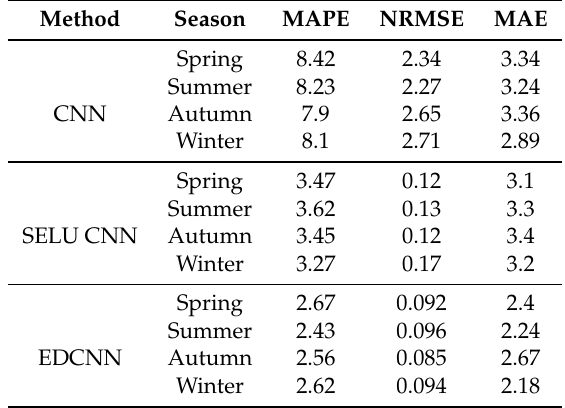
Table 3. MAPE and NRMSE of proposed and compared